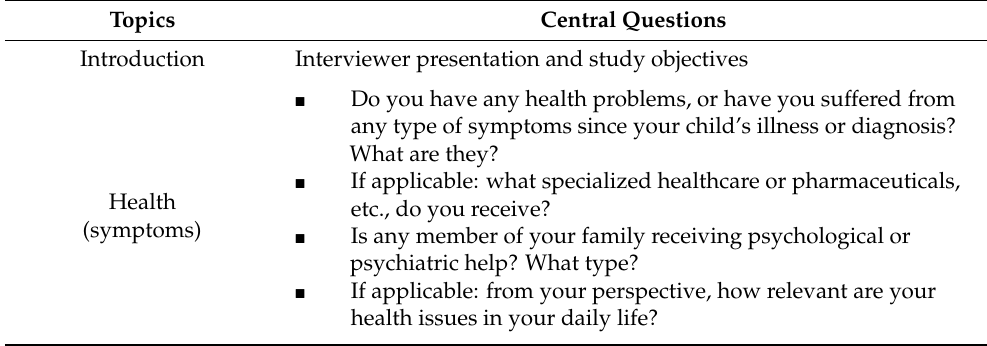
Table 1. Overview of the interview questions (in order of